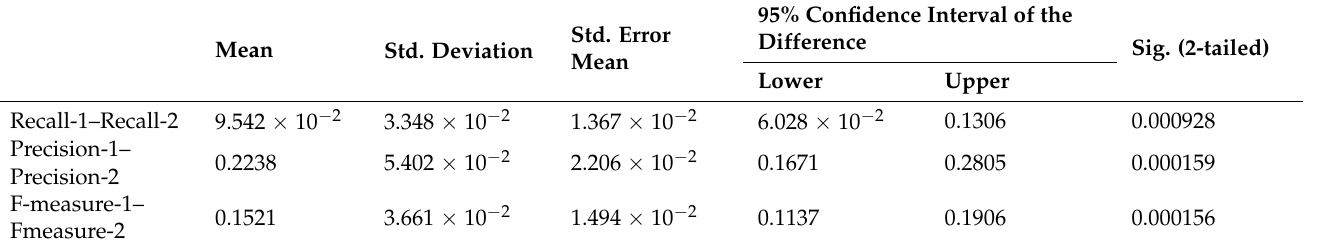
Table 3. Statistical significance testing using the t